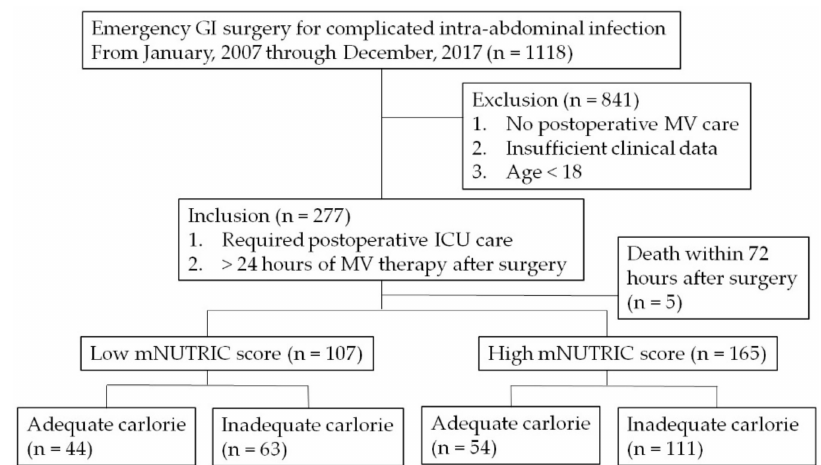
Figure 1. Flow diagram of patients selected for analysis. GI: gastro-intestinal; MV: mechanical ventilation; ICU: intensive care unit; mNUTRIC: modified NUTrition RIsk in the Critically